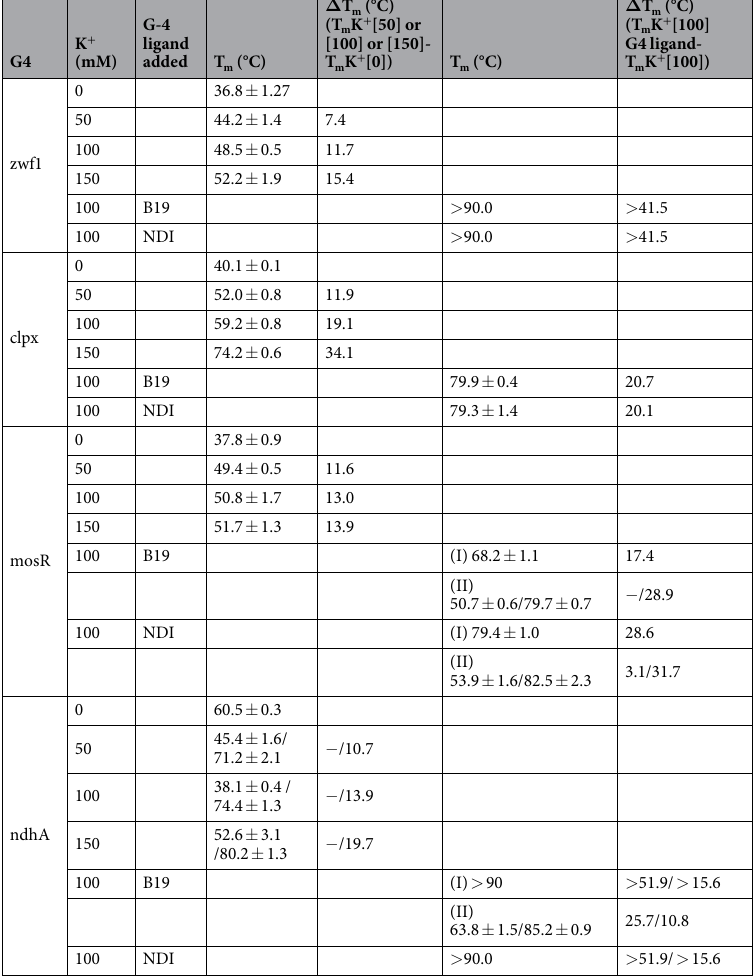
Table 3. Melting temperatures (T m ) of Mtb G4 oligonucleotides (4 µ M) in the absence and presence of increasing KCl concentrations (50–150 mM) and G4 ligands (16 µ M). When more than one G4 species were observed in the CD spectrum (i.e. I, II), T m values for each species were reported. B19 and NDI stand for the G4 ligands BRACO-19 and c-exNDI 2,